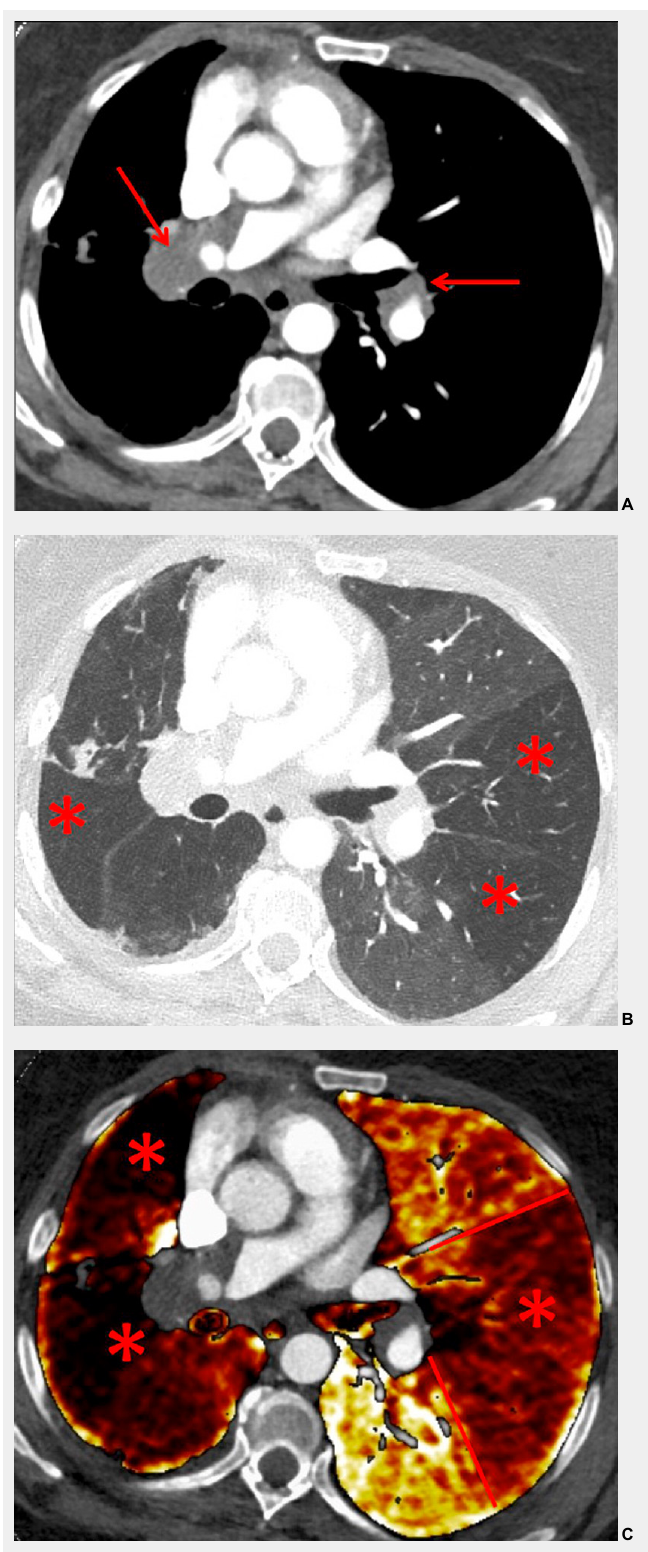
Figure 2 Chronic thromboembolic pulmonary hypertension (CTEPH). Vascular ( A ) and parenchymal ( B ) signs of CTEPH with proximal marginal occlusion (arrows) and mosaic pattern (stars). Functional information simply added with triangular perfusion defects (stars) on the iodine maps ( C